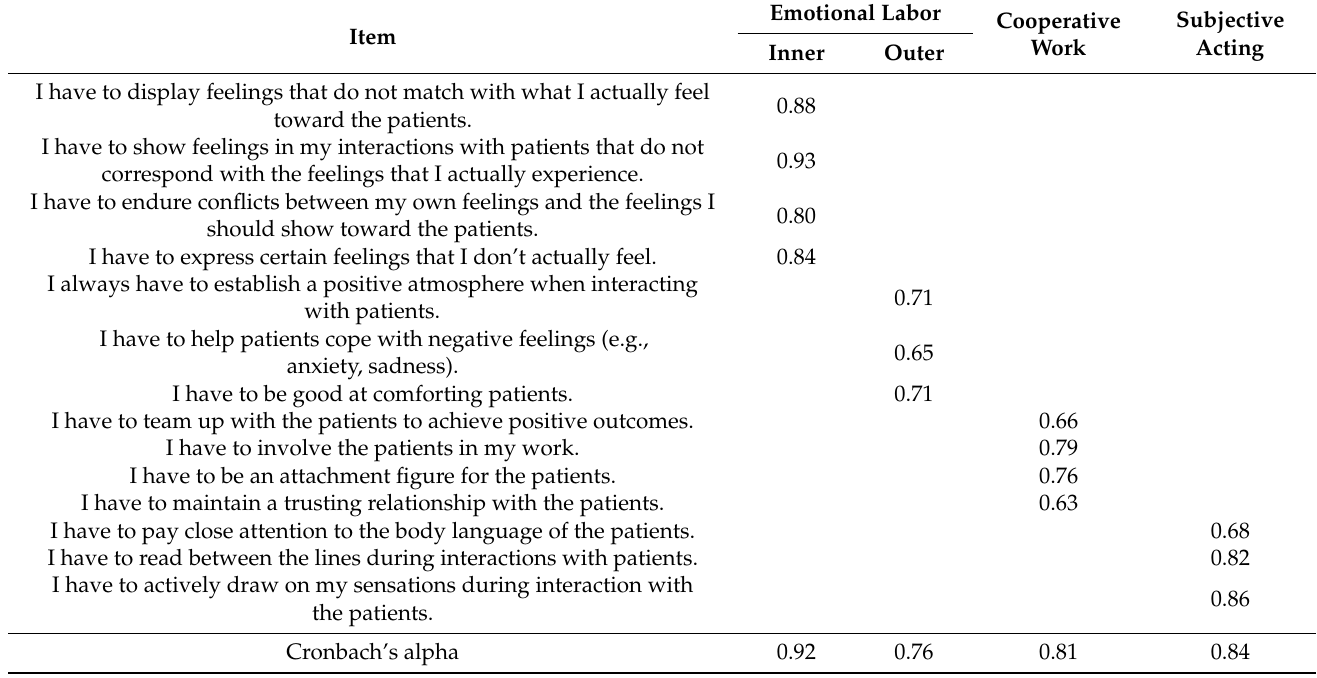
Table 2. Factor Loadings and Alphas for Interactive Work Demands Measures. Item